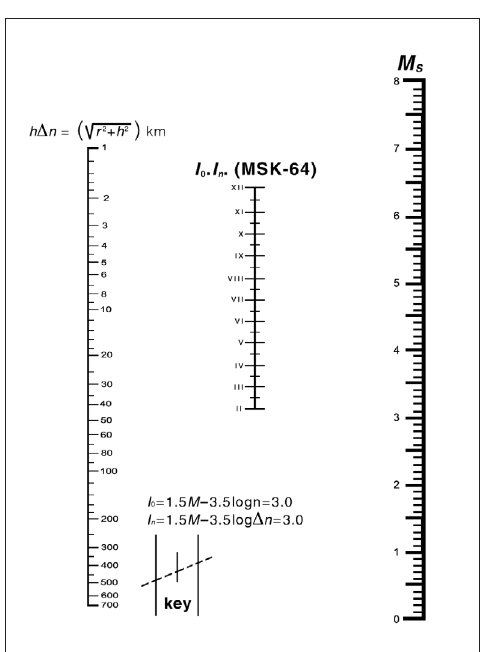
Fig. 4. Standard nomograph of M , h , ∆ and I . It is averaged for shallow earthquakes ( b = 1.5, ν= 3.5, c =3) (Shebalin,